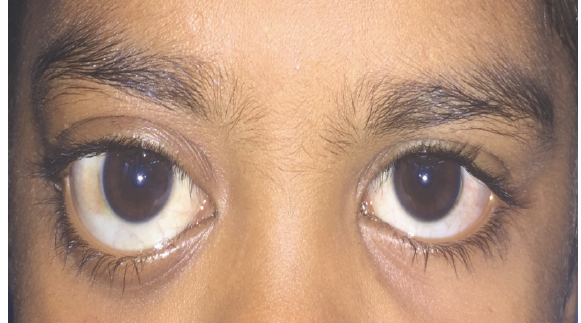
Figure 2: Post-injection photograph of the patient with reduction in